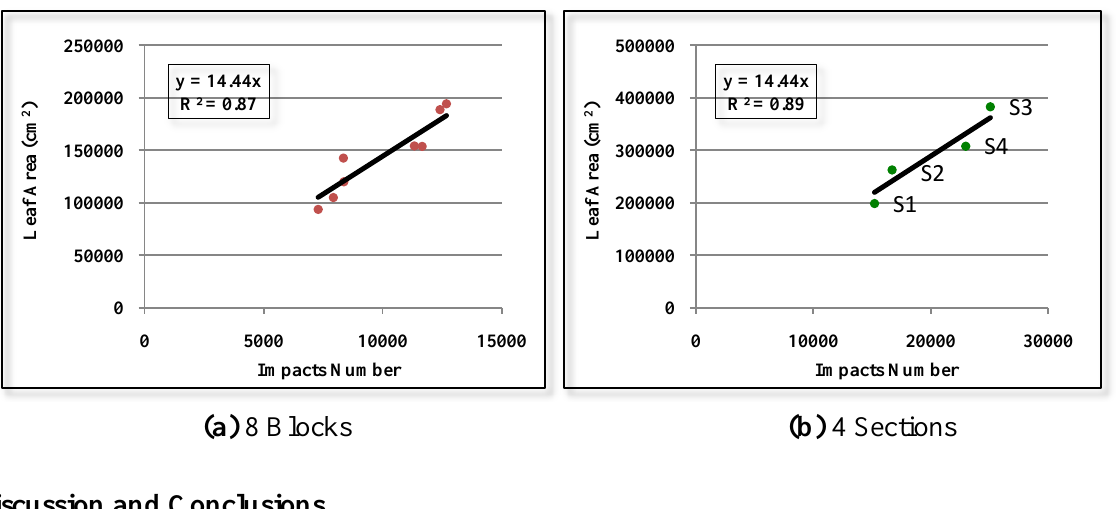
Figure 21. Scatter diagram, regression line and R 2 of the relation between the number of impacts and leaf area (cm 2 ) (a) ignoring the divisions by layer. (b) Also ignoring the “a” and “b” division between